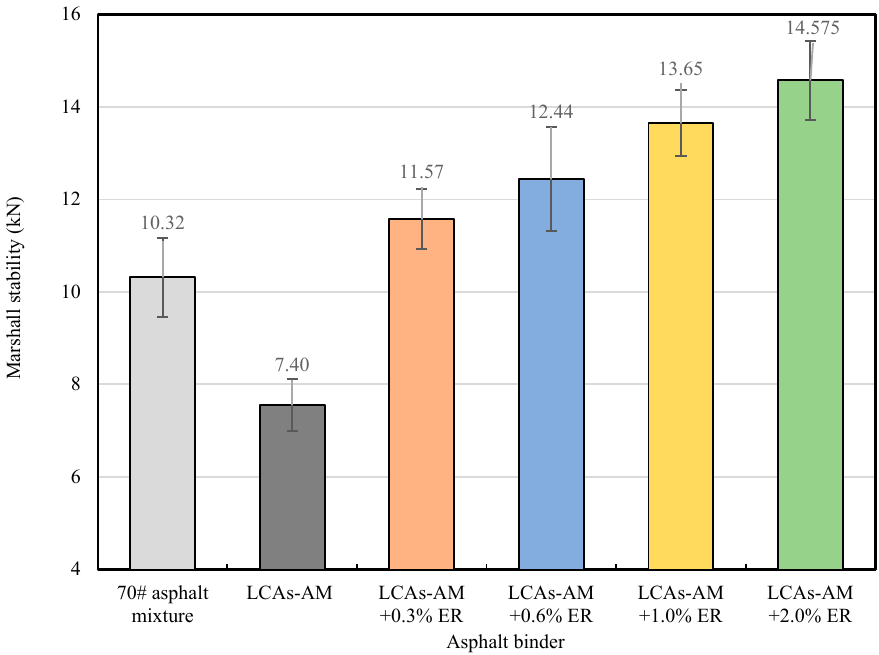
Figure 6. MS of LCA-AMs with different dosages of ER.